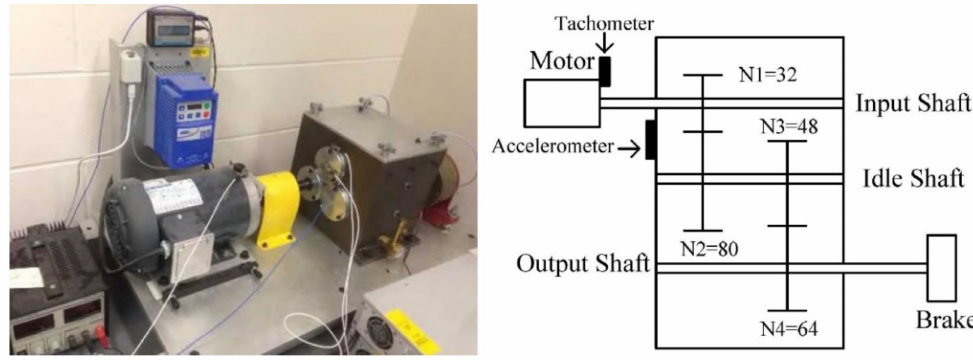
Figure 5. Gearbox test rig of University of Connecticut [6].